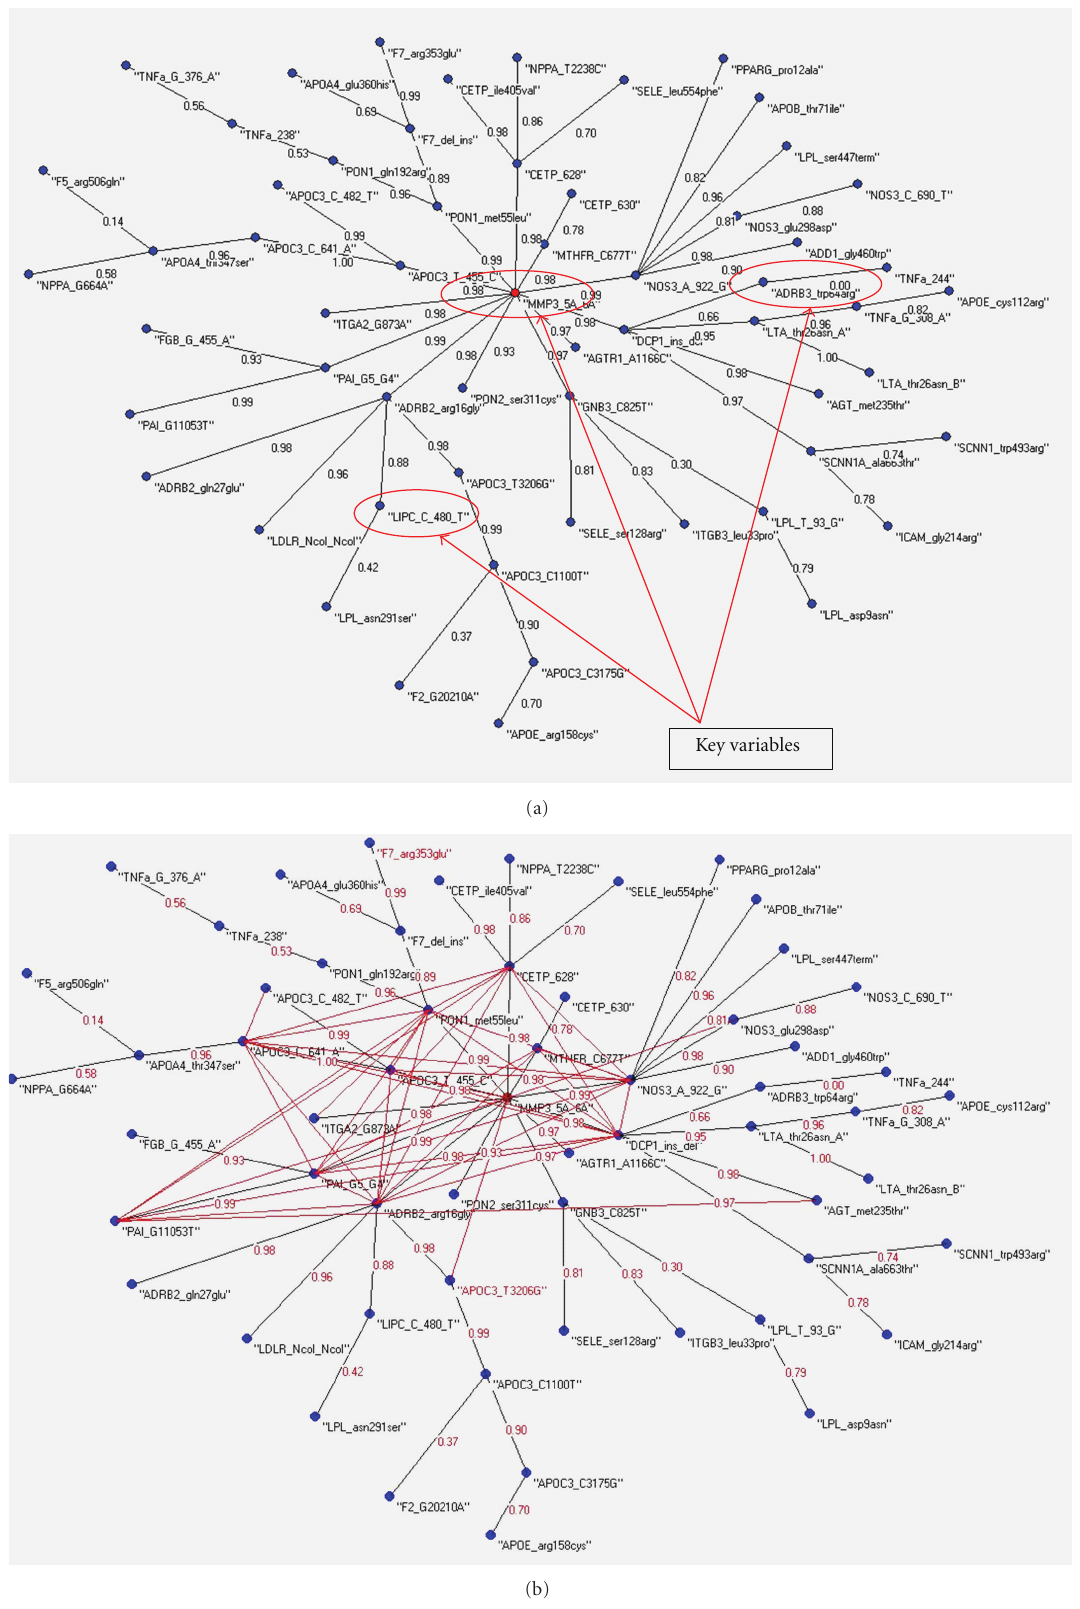
Figure 3: (a) The MRG of the cases databest. In red the MRG connections. (b) The MRG of the controls databest. In red the MRG